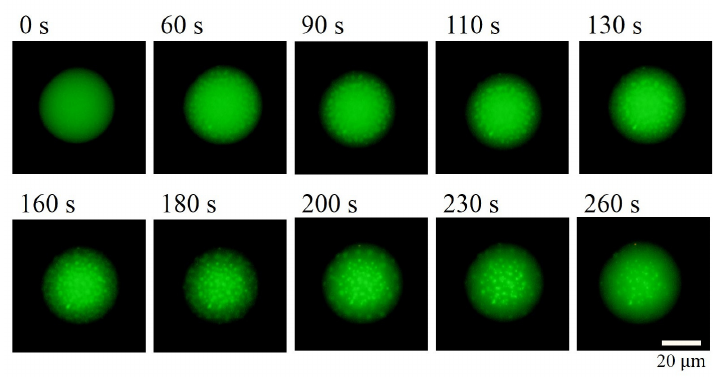
Figure 3. Typical microscopic images of hydroxypropyl cellulose (HPC) droplet with elapsed time when we changed the temperature from 10 ◦ C to 65 ◦ C. The dot-like phase-separation pattern appeared with an increase in temperature. The phase separation progressed from the interface to the centre of the droplet. The bright region corresponds to the water-rich phase, while the dark region inside the droplet corresponds to the HPC-rich